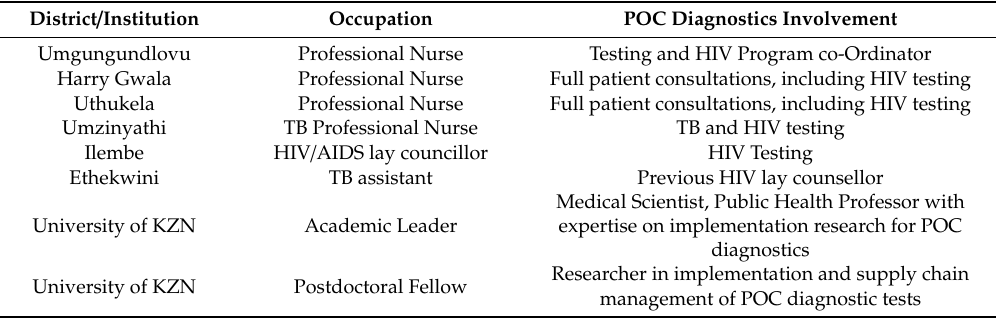
Table 1. Key stakeholder characteristics and involvement in point-of-care (POC) diagnostic services.